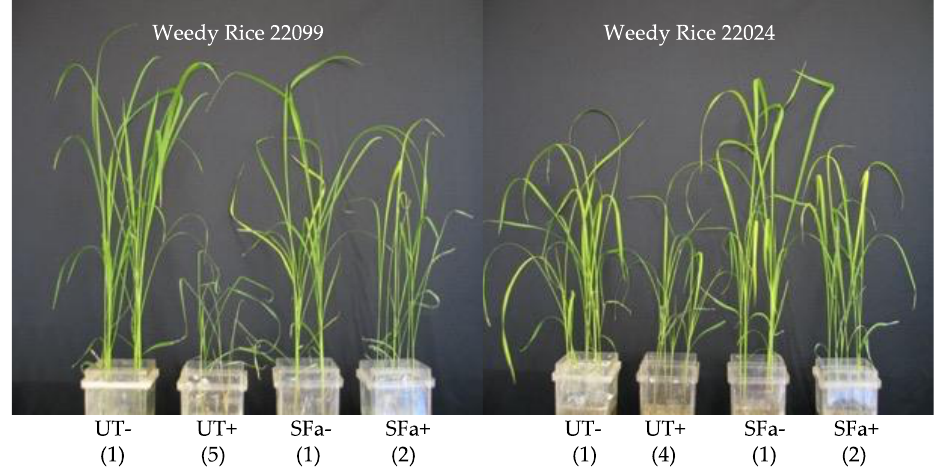
Figure 2. Drought and Salt Responses of Weedy Rice Lines. Untreated (UT) and symbiotic (S) plants were generated with native endophytes isolated from weedy rice lines from drought (SCb; C. brachyspora ) or salt stress (SFa; F. asiaticum ) habitats. Representative photo of magenta box studies showing: ( A ) Drought tolerance performed on one-month old plants of weedy rice drought tolerant plant lines 2861 (panel A-left) and 2716 (panel A-right) in the absence ( − ) and presence (+) of drought stress (devoid of water for 10 days) of UT (untreated) and symbiotic plants (SCb); ( B ) Salt tolerance assays were performed on 2-week old weedy rice drought tolerant plant lines 22099 (panel B-left) and 22024 (panel B-right) in the absence ( − ) and presence (+) of salt stress (exposure to 300 mM NaCl for 14 days) of UT (untreated) and symbiotic plants (SFa). Assays were conducted with six plants/magenta box and 4 magenta boxes per treatment. Plant health was numerically scored collectively for the six plants in each magenta box. The Kruskal–Wallis as a non-parametric test was utilized as the plant health metric is categorical data. Plant health is represented by the numbers under the plants. Regardless of the stress, S plants out performed their UT counterparts (Weedy Rice 2861 H(1) = 7, p = 0.008151; Weedy Rice 2716 H(1) = 6.4, p = 0.01141; Weedy Rice 22099 H(1) = 7, p = 0.008151; Weedy Rice 22024 H(1) = 6.22, p = 0.01262). No significant differences in plant health was observed with treatments in the absence of